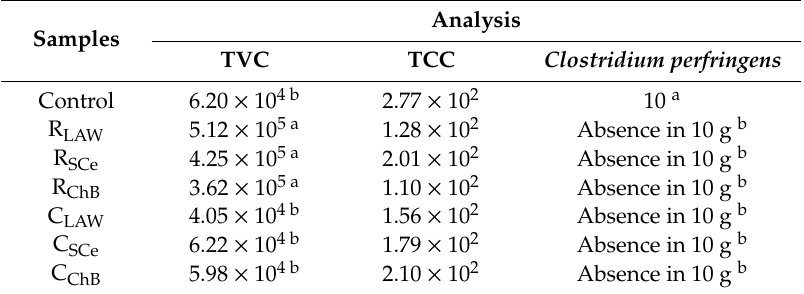
Table 5. Microbiological results (cfu / g) of Spanish chorizo analysis after 50 days under refrigerated